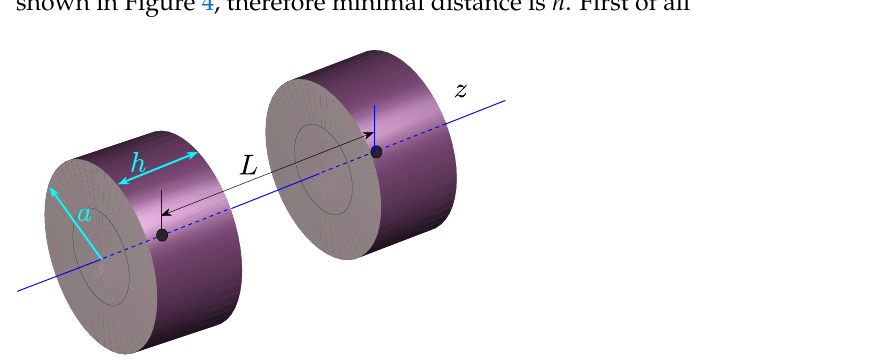
Figure 4. Two coaxial dielectric disks with (cid:101) = 12 separated by distance L measured between the centers of disks.